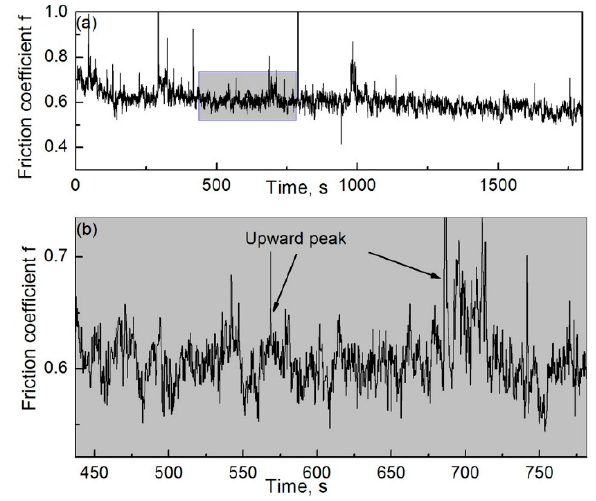
Figure 17 Friction–coefficient evolution during the friction process when the RD was used; H = 26.1 × 10 3 A/m. ( a ) Complete drawing and ( b ) local enlarged drawing of the shadowed region in (a).